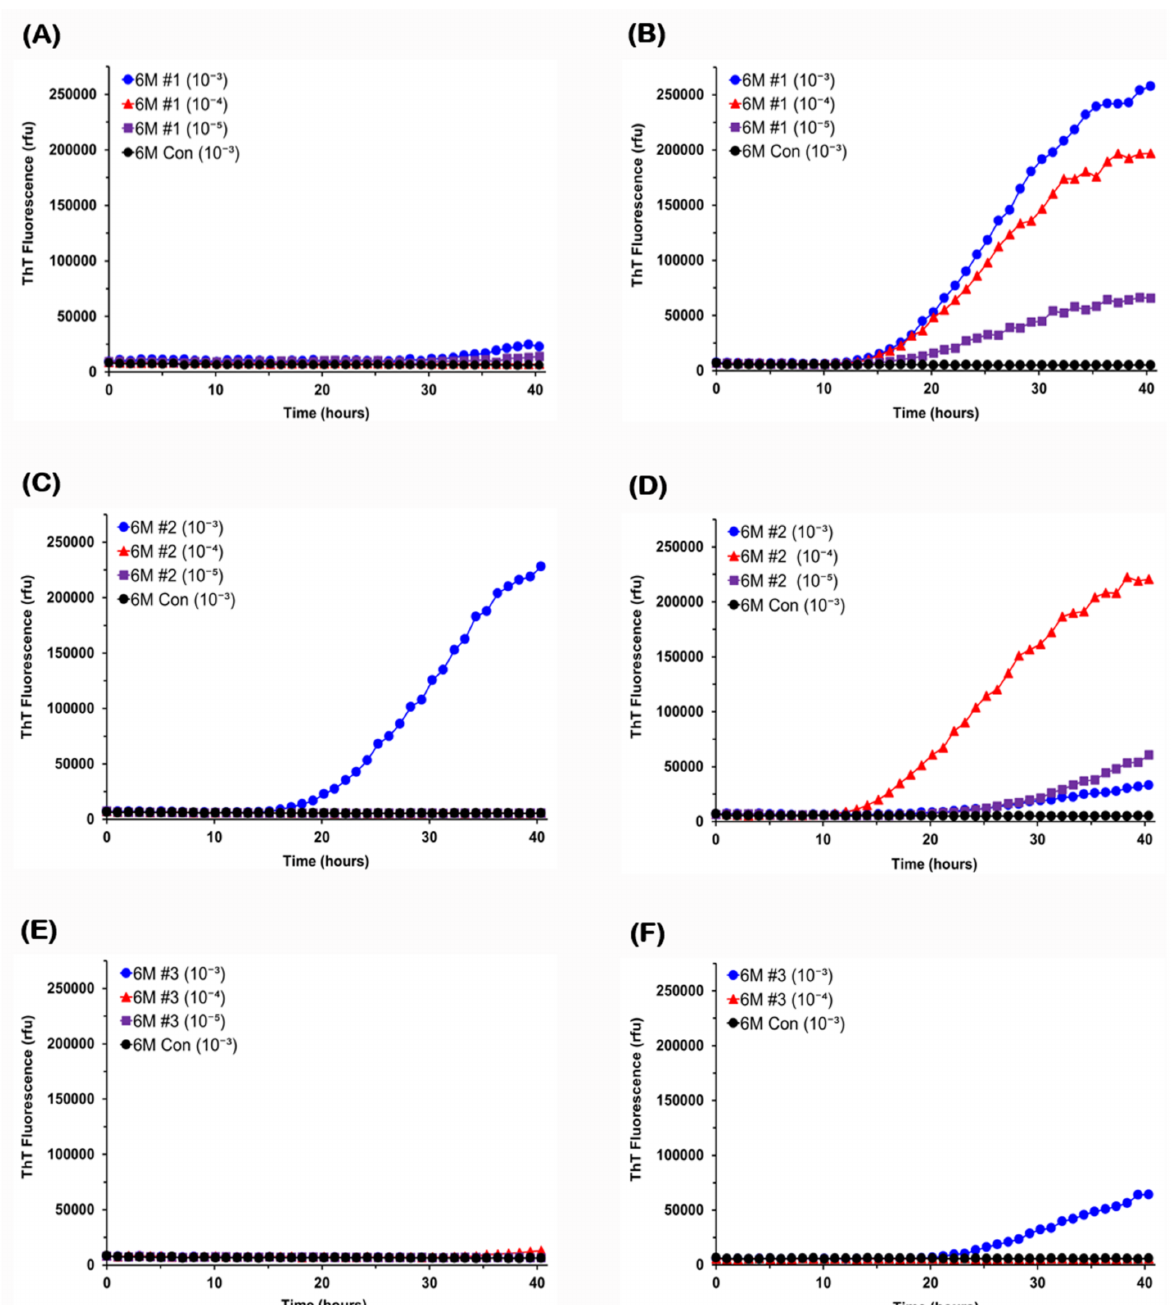
Figure 2. RT-QuIC analysis of brain and colon samples from 6-month-old G2-3 mice. Serial dilutions of brain or colon homogenates (10 − 3 to 10 − 5 ) from 6-month-old G2-3 mice were used to seed RT-QuIC reactions with A53T recombinant α -syn as substrate. RT-QuIC responses to brain samples were shown in the left column ( A , C , E ) and those to colon samples were shown in the right column ( B , D , F ). As controls, reactions were also seeded with 10 − 3 dilution of brain tissue or colon tissue from a non-carrier mouse of the same age. ThT fluorescence was measured at one-hour intervals and average values from quadruplicate wells were plotted as a function of